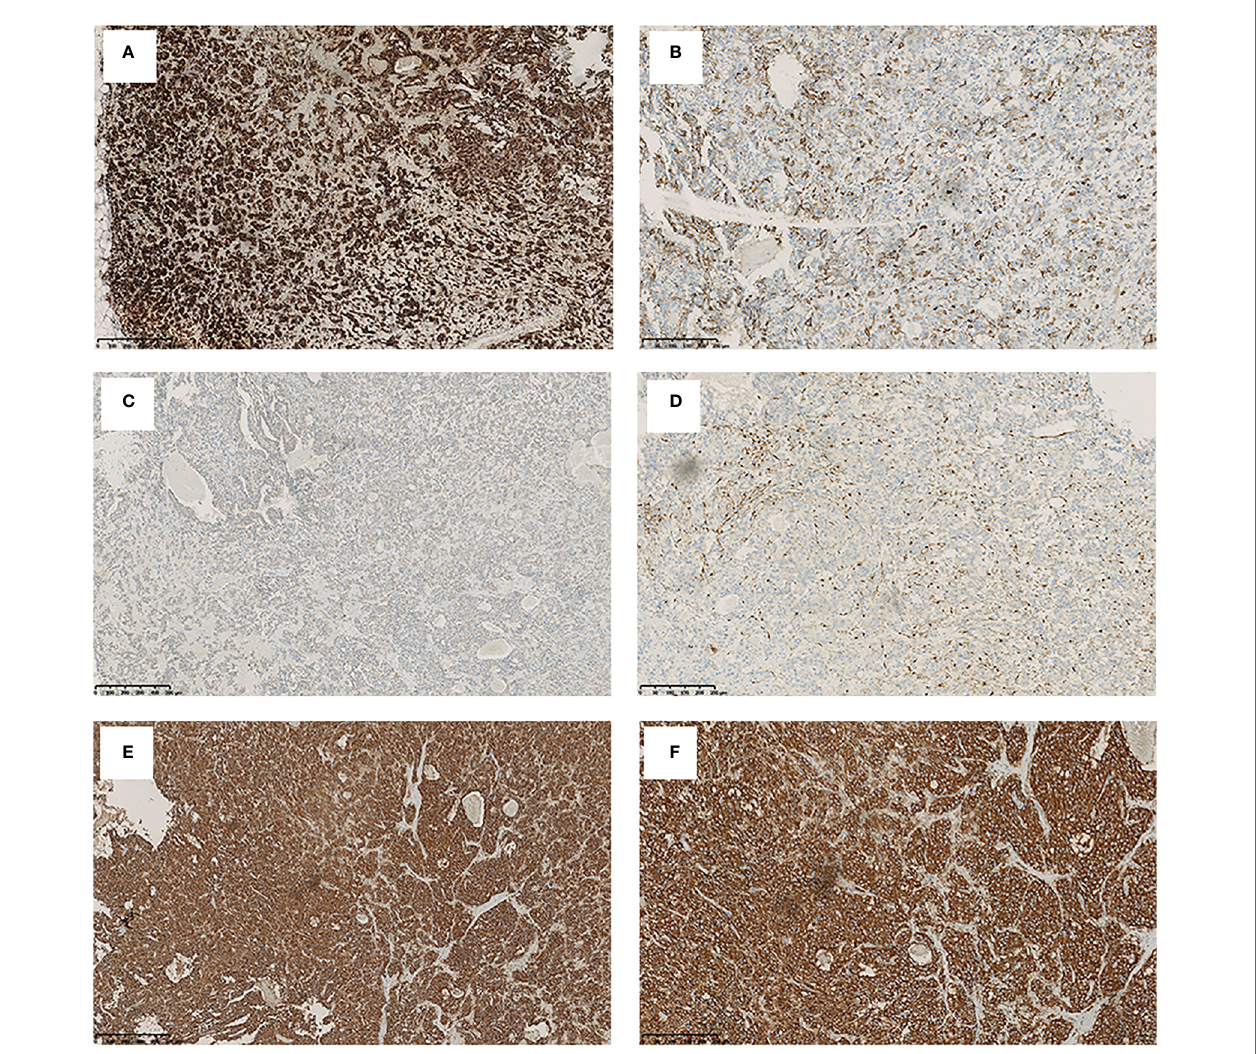
FIGURE 2 | The immunohistochemical staining pattern of mediastinal mass. Tumor cells show a positivity for adrenocorticotrophic hormone (A) (original magni fi cation, ×100), chromogranin A (B) (original magni fi cation, ×200), PCK (C) (original magni fi cation, ×100), and S100 (D) (original magni fi cation, ×200) and synaptophysin (E, F) (original magni fi cation, ×100 and ×200).